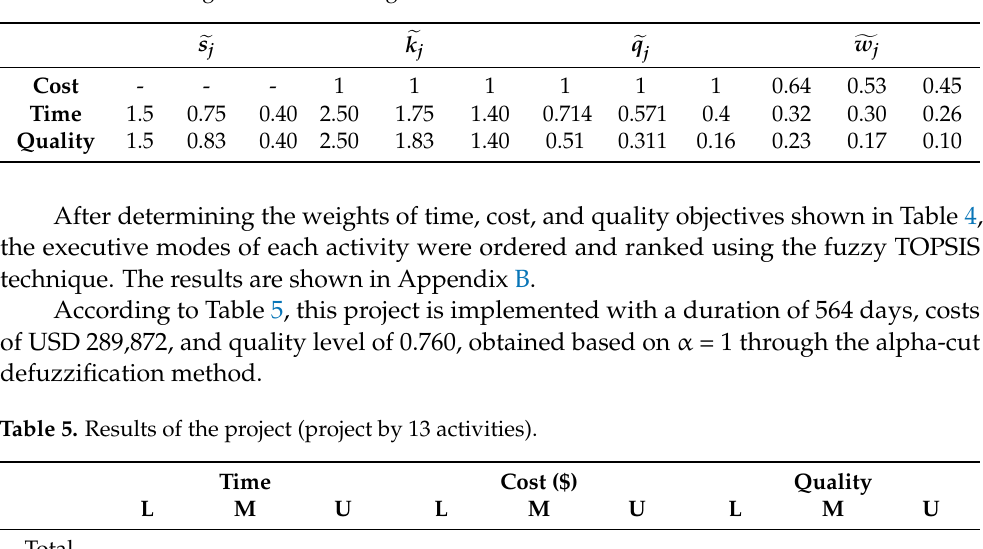
Table 4. Criteria weights obtained using the SWARA method.